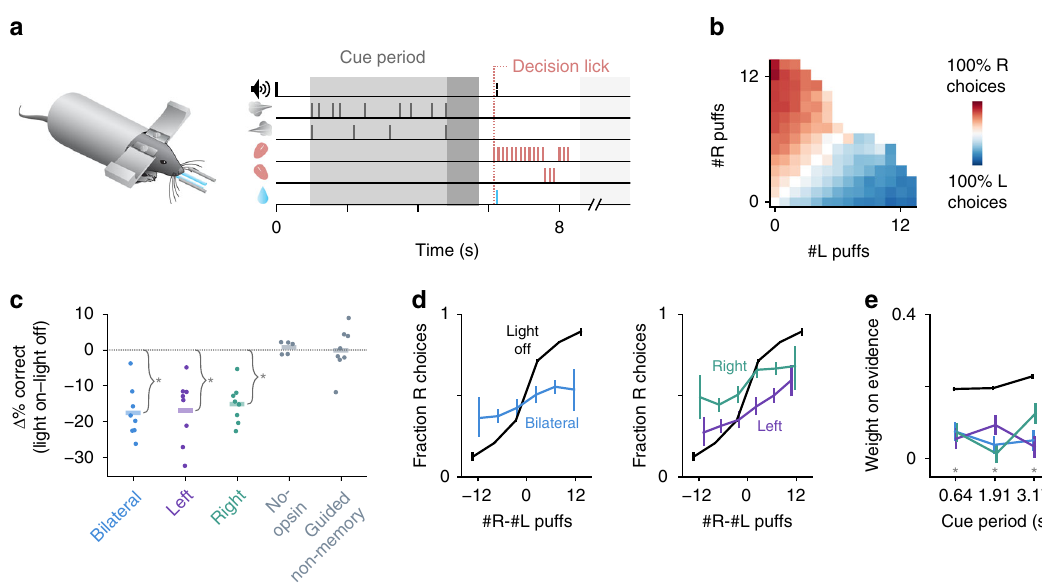
Fig. 1 Cerebellar disruption during evidence accumulation impairs decisions. a Schematic of the evidence-accumulation decision-making task. In each trial, two streams of randomly timed air puffs were delivered to the left and right whiskers. After an 800-ms delay, mice licked one of two lick ports indicating the side with more cumulative puffs to receive a water reward. Gray-shaded regions from left to right: cue period, delay, intertrial interval. Decision lick: fi rst detected lick after the delay. b Choice probabilities as a function of the number of left- and right-side puffs ( n = 96,254 trials over 664 sessions in 13 mice). c Change in performance as a result of cue-period light delivery to the left, right, or bilateral cerebellum ( n = 46,435 light-off trials, 5392 light-on trials, 397 sessions, 8 mice). Dots: individual mice. Lines: mean across mice. * p < 0.01 (two-tailed paired t -test). No-opsin: bilateral light delivery in ChR2 – mice (also see Supplementary Figure 3). Guided non-memory: bilateral light delivery in trials where mice were guided to lick the correct side by delivery of all- single sided puffs during the cue period and delay. d Psychometric curves for light-off (black) trials and light-on (colored) trials from all perturbation sessions in all experimental mice. Results are shown for bilateral (left) and unilateral (right) perturbations. Error bars: 95% CI. e Regression of animal choices on evidence quantity throughout the cue period for light-off (black) and light-on (colored) trials. Weights indicate the extent to which evidence was used to guide decisions, and the sum of weights is proportional to overall performance. * p < 0.01 (99% CI, light-off: 0.18 – 0.21, 0.18 – 0.21, 0.21 – 0.25; bilateral: 0.01 – 0.15, − 0.03 – 0.11, − 0.02 – 0.13; left: − 0.02 – 0.13, 0.02 – 0.16, − 0.04 – 0.11; right: 0 – 0.14, − 0.05 – 0.08, 0.05 –